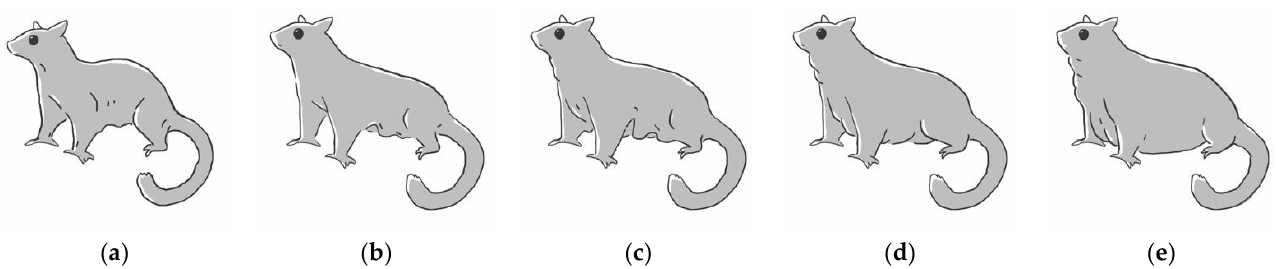
Figure 1. Reference figures for body condition scoring. ( a ) Score 1, no subcutaneous fat at neck/chest region, ribs easily palpable with no fat covering, thin patagium; ( b ) Score 2, minimal subcutaneous fat at neck/chest region, ribs easily palpable with little fat covering, thin patagium; ( c ) Score 3, slight subcutaneous fat at neck/chest region, ribs palpable with slim fat covering, thin patagium; ( d ) Score 4, thick subcutaneous fat at neck/chest region, ribs not easily palpable with moderate fat covering, patagium thickened with fat deposit; ( e ) Score 5, pronounced subcutaneous fat at neck, chest, and abdominal region, ribs not palpable with substantial fat covering, patagium thickened with substantial fat deposit.